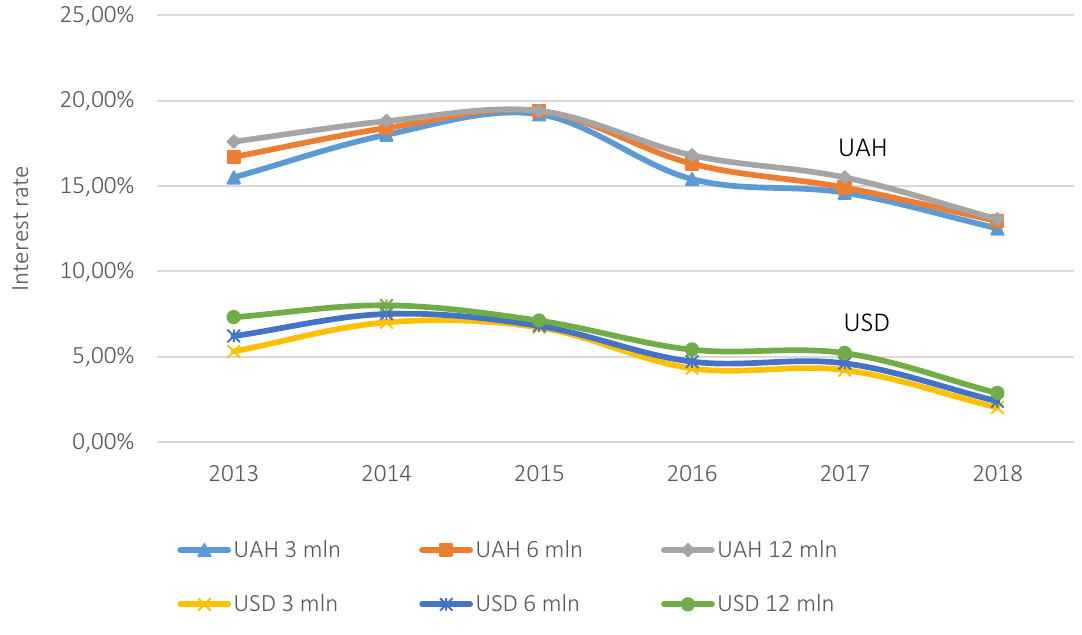
Figure 4. Interest rate (mean) on deposits in UAH and USD in